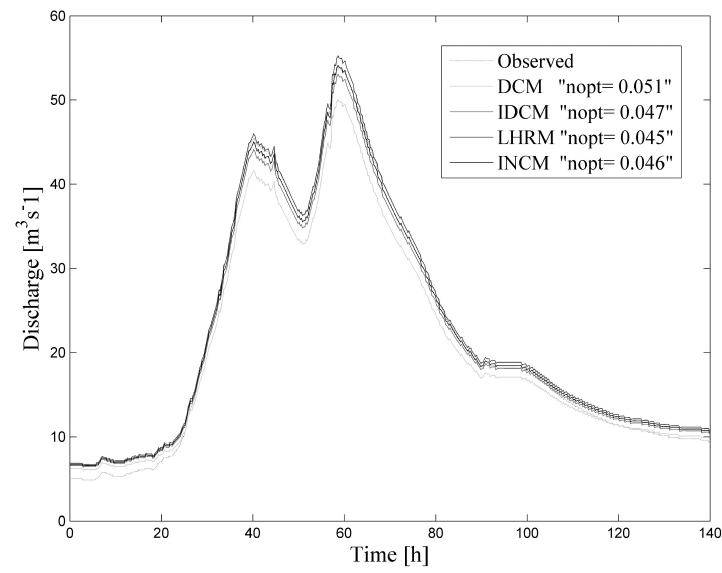
Figure 9. Observed and simulated discharge hydrographs at the Pfaffenthal gauged site in the event of January 2007.